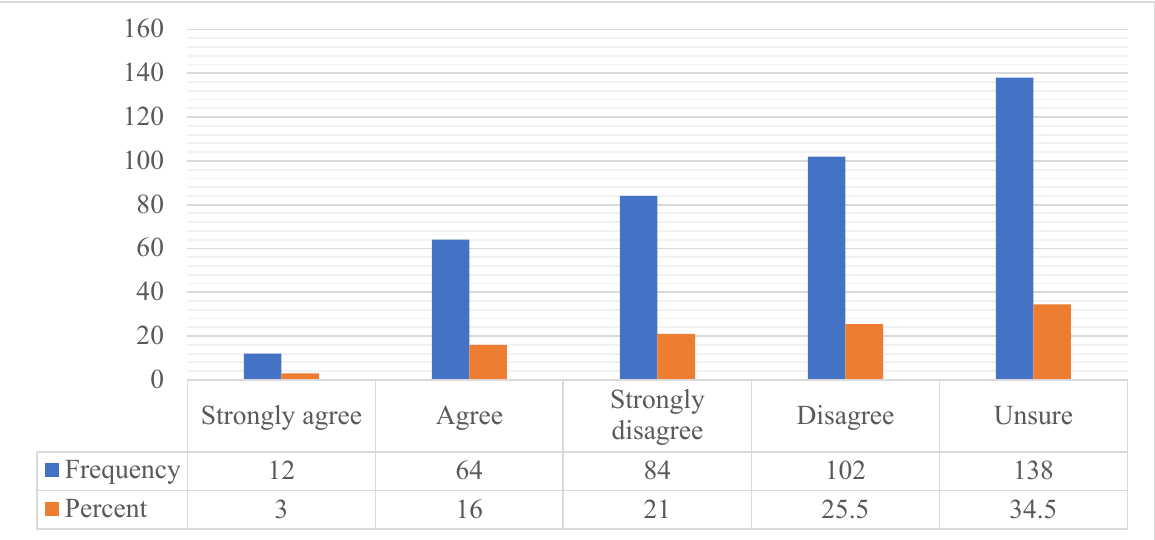
Figure 3. Delivered Projects and Services as Stipulated in the IDP Document. Source (Mamokhere and Meyer 2022).